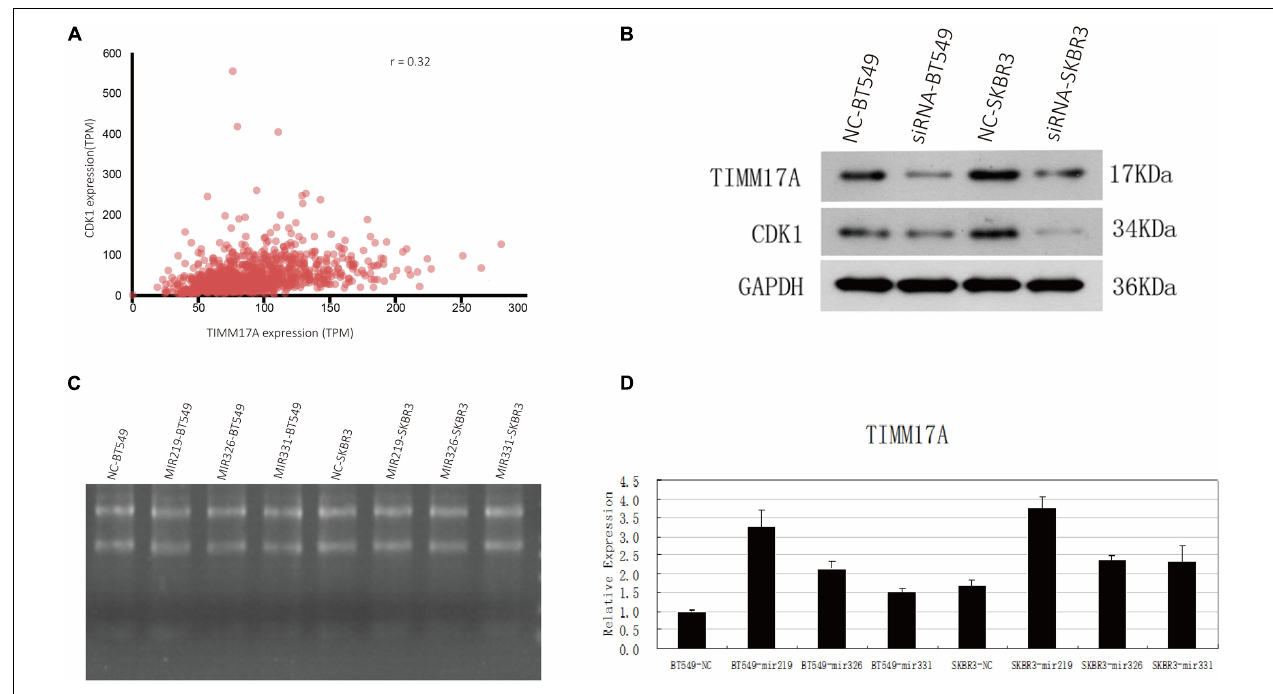
FIGURE 10 | Associations of TIMM17A expression with CDK1 expression and microRNAs expression levels. (A) Relationship between TIMM17A and CDK1 expression levels. (B) Western blot analysis showing the effects of TIMM17A knock down on the expression levels of CDK1 and GAPDH . (C) RNA electrophoretogram of miRNA 219, miRNA 326, and miRNA 331 in BRCA cells. (D) Expression levels of miRNA 219, miRNA 326 and miRNA 331 in TIMM17A knockdown BRCA cells.